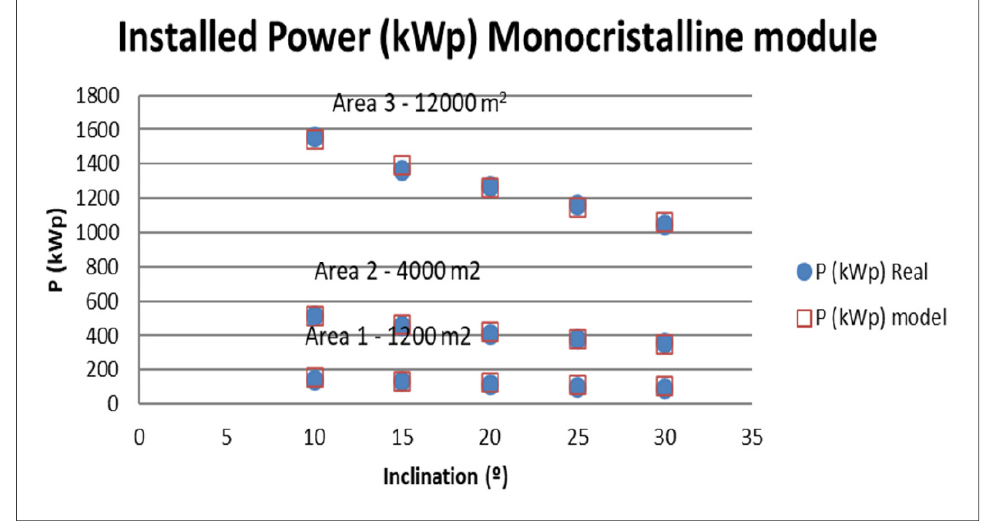
Figure 17. Real installed power and power estimated by the model. Yield